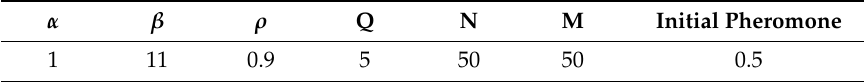
Figure 7. The iterative process of the ant colony algorithm . Table 2. Ant colony algorithm (ACO) Parameters.